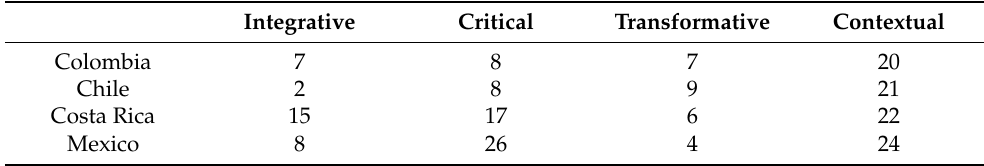
Table 1. Frequency of references to ESD approaches in curriculum documents. Integrative Critical